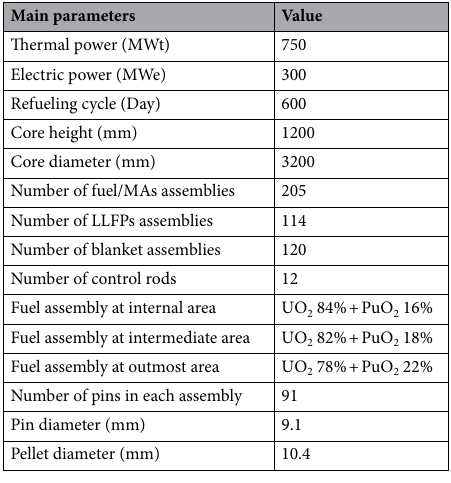
Table 2. The main parameters of the LFR used in the simulation.